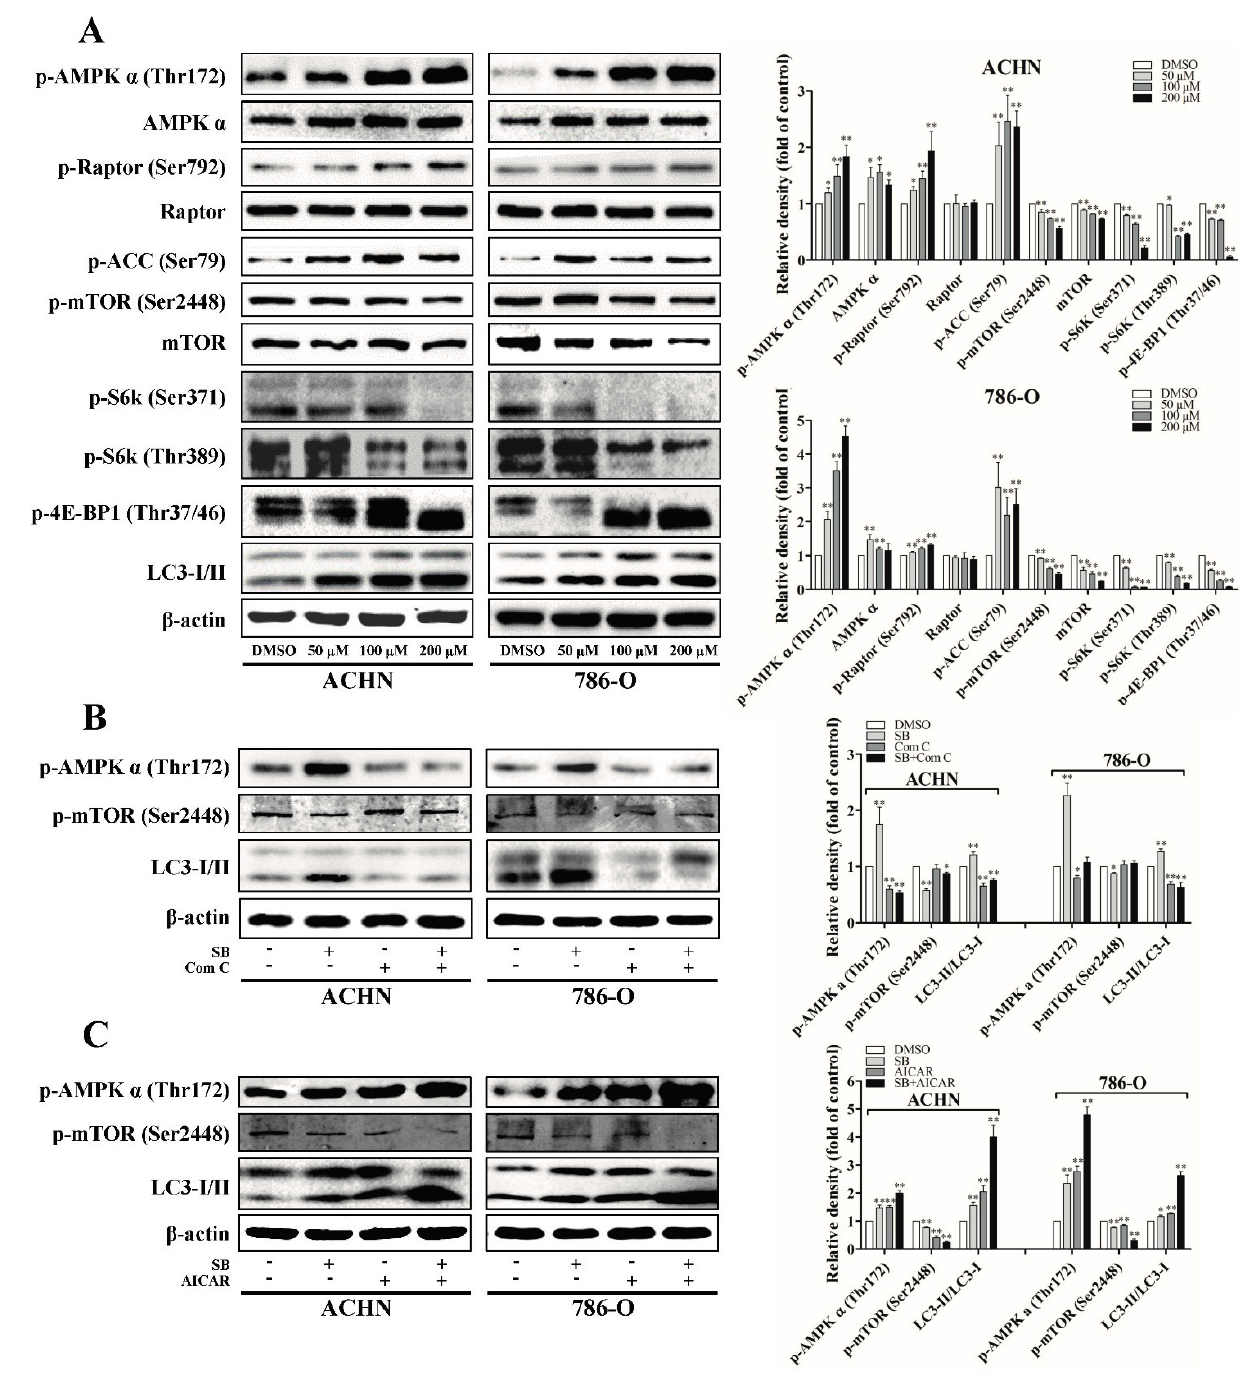
Figure 3. Silibinin induces autophagy through the AMPK/mTOR pathway. ( A ) Cells were treated with indicated doses of silibinin (SB) for 24 h and the protein levels of p-AMPK α , p-ACC, p-Raptor, p-mTOR, p-S6K, and p-4E-BP1 were checked. RCC cells were pre-incubated with AMPK inhibitor Compound C (Com C, 5 μ M) ( B ) or activator AICAR (1 mM) ( C ) for 4 h and then treated with silibinin (50 μ M) for 24 h. The levels of p-AMPK α , p-mTOR, and LC3-I/II were examined. Blots are representative of three separate experiments. Error bars represent SDs. * p < 0.05; ** p <